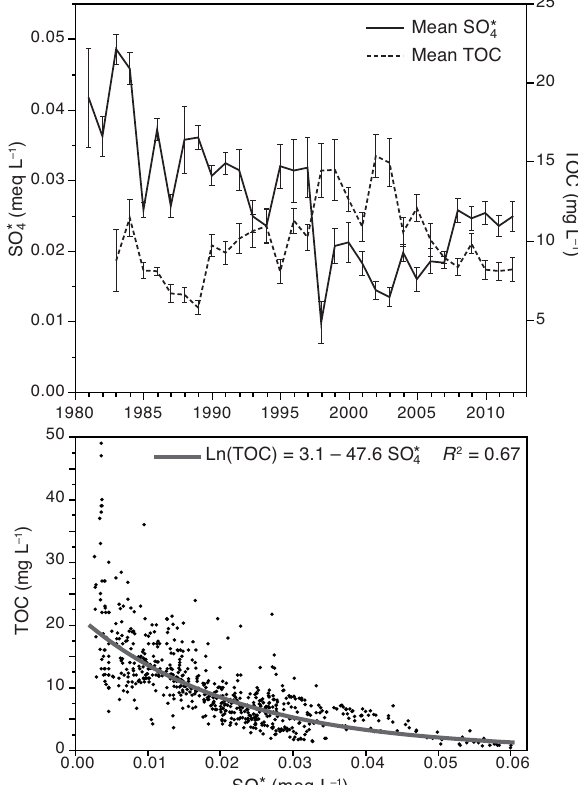
Fig. 4. Upper panel: trends in non-marine sulfate (SO ∗ ganic carbon (TOC) in the streams during the study period (annual mean, standard error). Lower panel: correlation between TOC and SO ∗ concentrations in stream water. Each point represents a sin- 4 gle sample. Data include the streams 5004 (with the two tributaries 5002, 5003), 5005, 5006, 5009, and 5111.